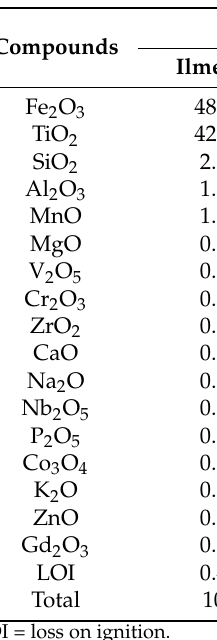
Table 2. Chemical analysis of the ilmenite ore with various sizes. Compounds